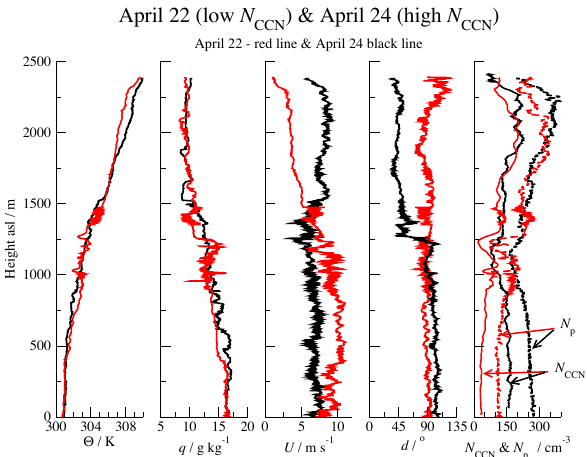
Fig. 7. Profiles of 20 April (black line) and 22 April (red line) de- rived from the first ascent of each flight. Shown are the potential temperature 2 , the water vapor mixing ratio q , horizontal wind ve- locity U and direction d and CCN number concentration N CCN at 0.25% supersaturation, and aerosol particle number concentration N p .